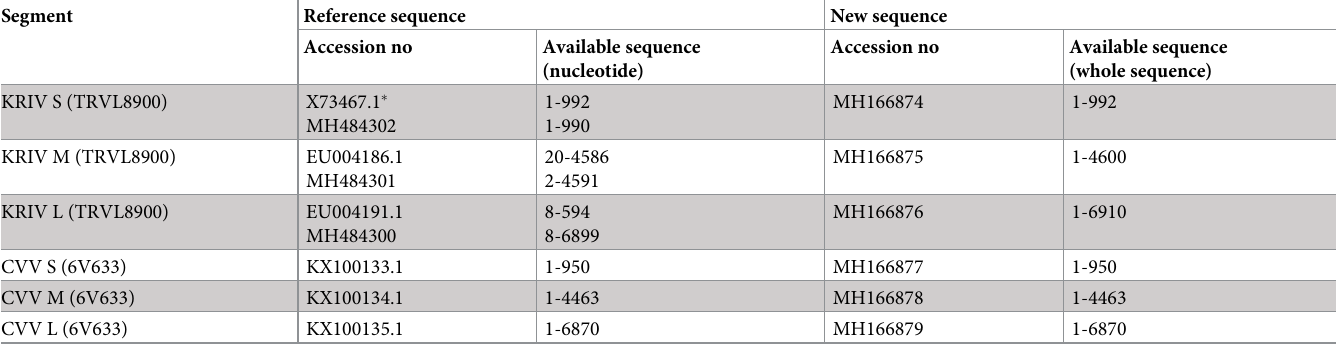
Table 1. Sequence coverage for KRIV (strain TR8900) and CVV (strain 6V633).